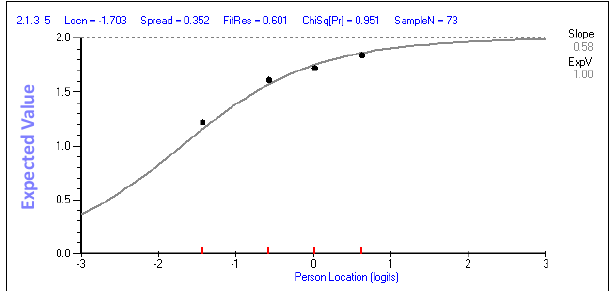
FIGURE 2 : Item characteristic curve for Item 2.1.3, indicating fairly good fit.